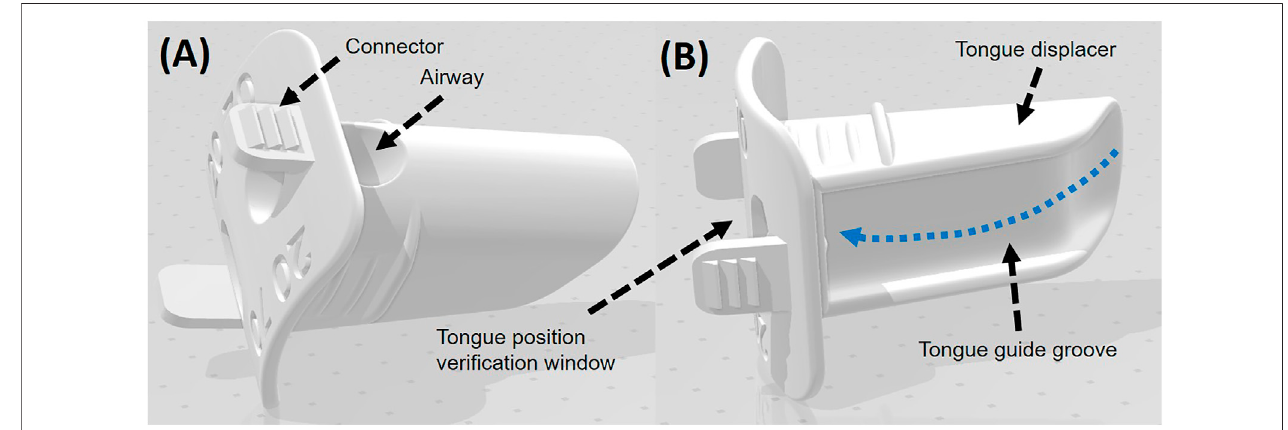
FIGURE 1 | Top (A) and bottom (B) views of the three-dimensional model for the semi-customized tongue displacement device (scTDD). The scTDD consists of airway, tongue displacer and tongue position veri fi cation window.